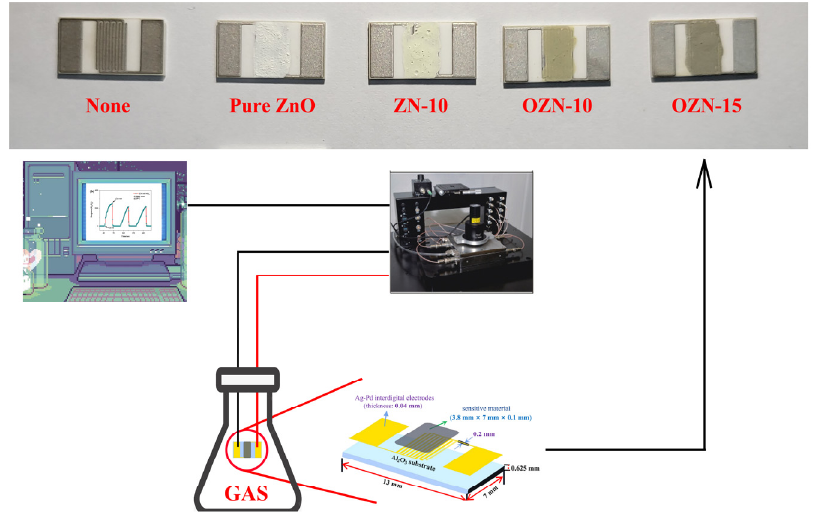
Figure 2. Schematic of the alumina substrate, sensor devices and gas sensor testing experimental system.